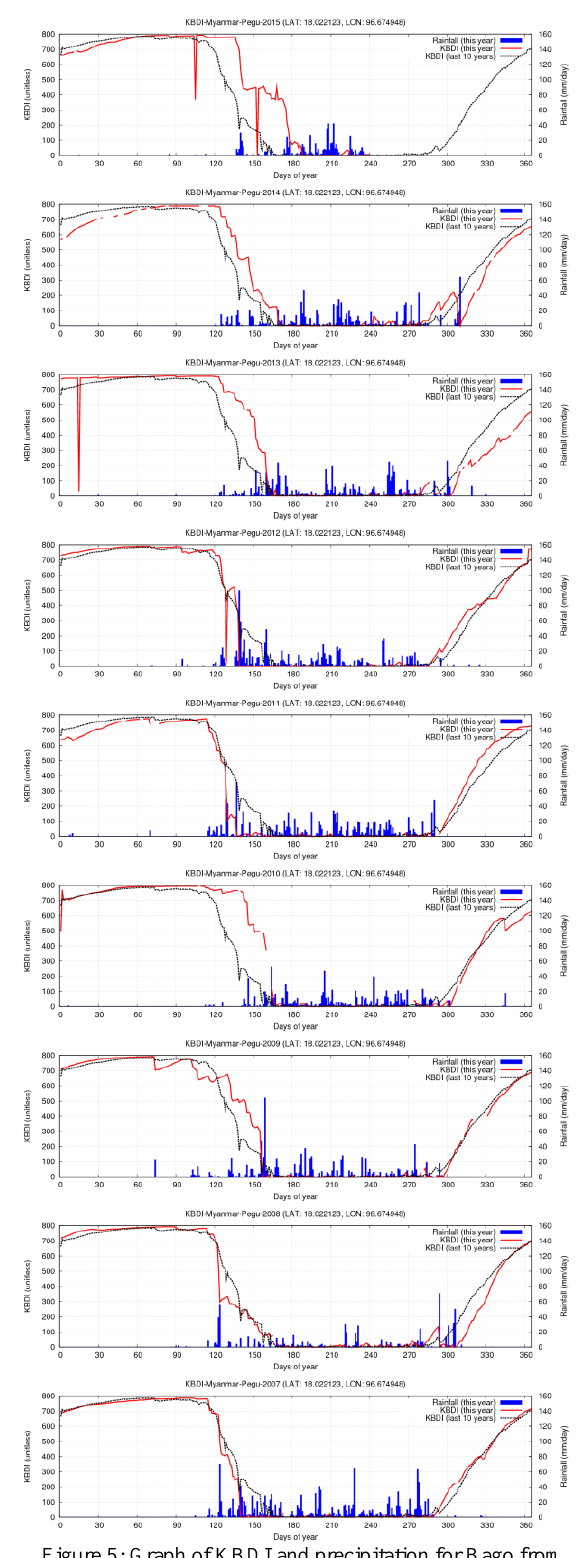
Figure 5: Graph of KBDI and precipitation for Bago from beginning of 2007 to mid of